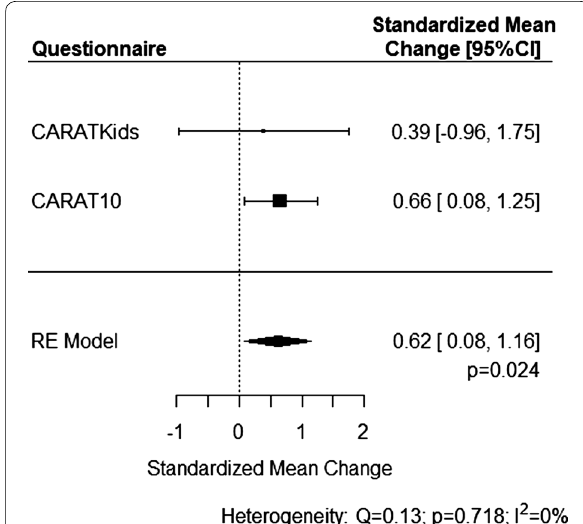
Fig. 5 Meta‑analysis of standardized mean changes (between day 1 and day 30) of CARAT results, pooling CARATKids and CARAT10 results